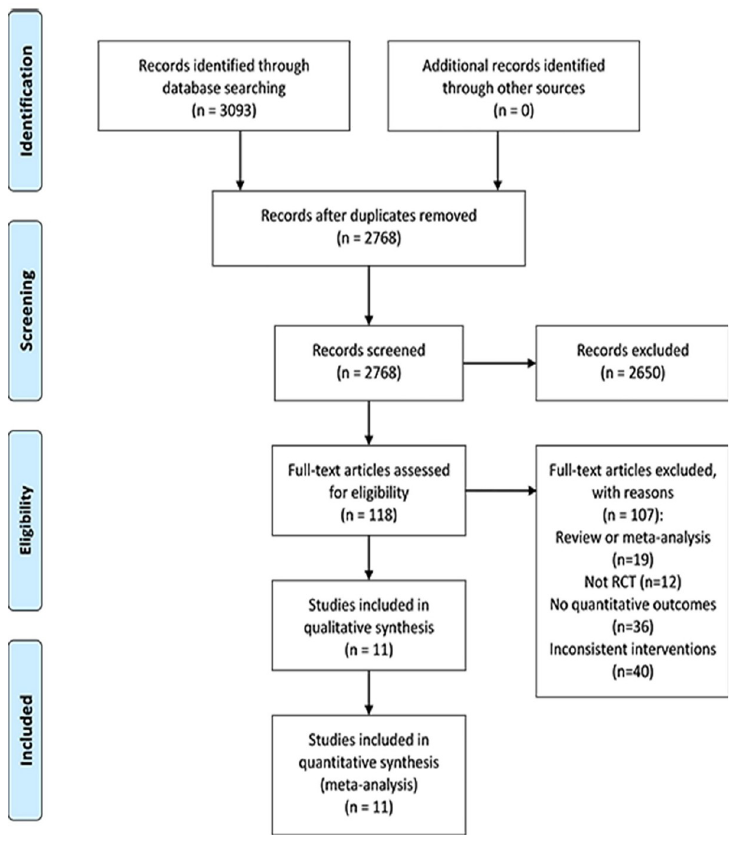
Fig 1. Flow diagram of study